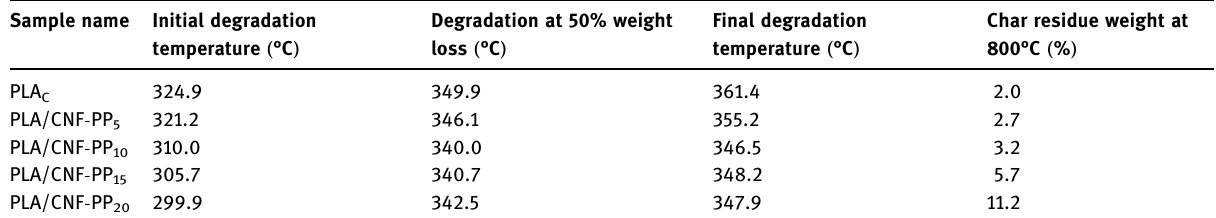
Table 3: TGA results obtained for the PLA C , PLA/CNF - PP 5 , PLA/CNF - PP 10 , PLA/CNF - PP 15 , and PLA/CNF - PP 20 sca ff olds